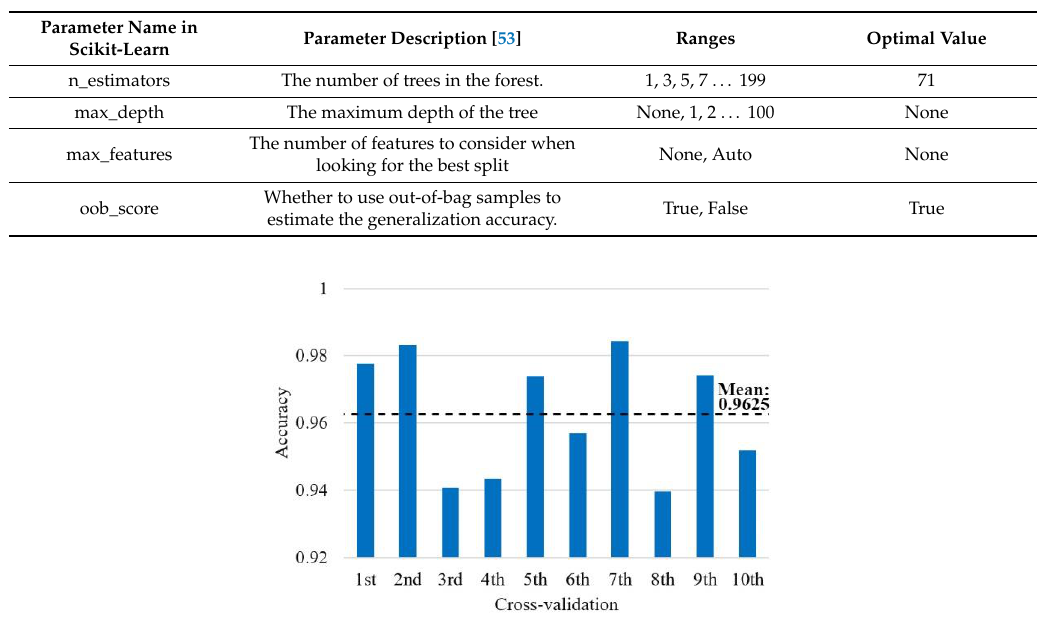
Table 4. RF model parameter list and main optimal combination of this model.